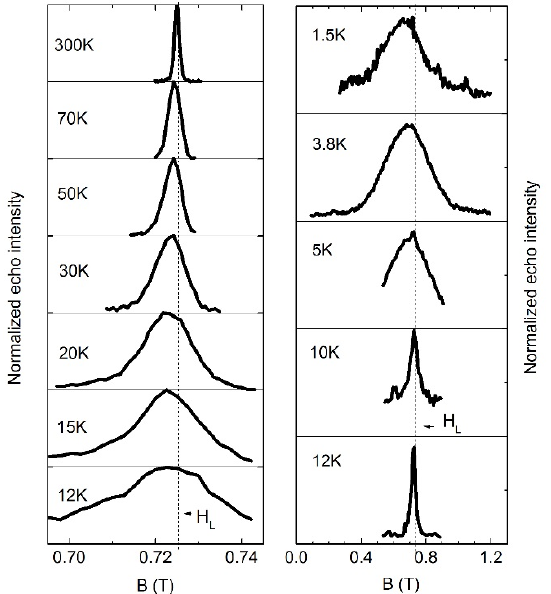
Figure 7. 7 Li NMR spectra at selected temperatures obtained at field of 0.724 T. Note that the scale on ( Right ) is enlarged compared to the ( Left ) one.